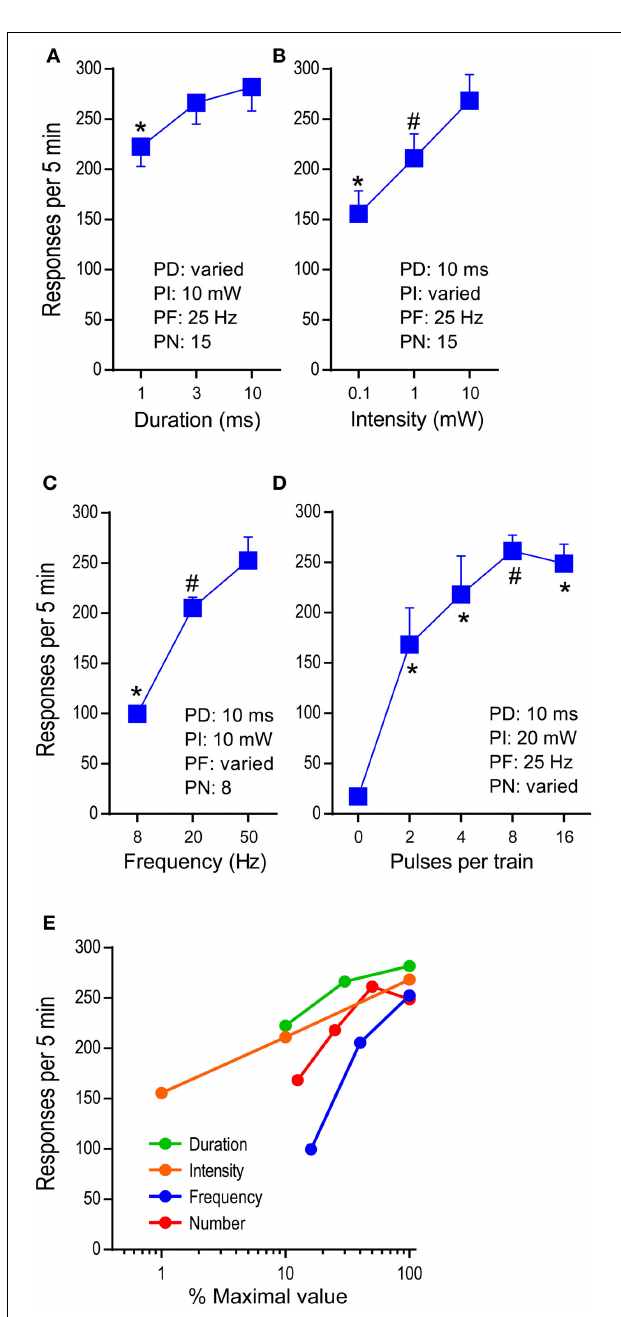
FIGURE 4 | Effects of parametric manipulations of photo-pulse trains on self-stimulation. The data are mean with s.e.m. (A) Pulse duration was varied. * P < 0 . 005, significantly lower than the 3- or 10–ms value. (B) Photo intensity was varied. * P < 0 . 01, significantly lower than the 1- or 10-mW value; # P < 0 . 05, significantly greater than the 0.1-ms value. (C) Pulse frequency was varied. * P < 0 . 005, significantly lower than the 20- or 50-Hz values; # P < 0 . 05, significantly greater than the 8-Hz value. (D) Pulse number was varied. * P < 0 . 005, significantly greater than the 0-pulse value; # P < 0 . 05, significantly greater than the 0- and 2-pulse values. (E) Summarized are effects of the factors: duration, intensity, frequency, and number. The maximal values of the factors (10ms, 10mW, 50Hz, and 16 pulses, respectively) are set at 100%, and the rest of the values of each factor are transformed